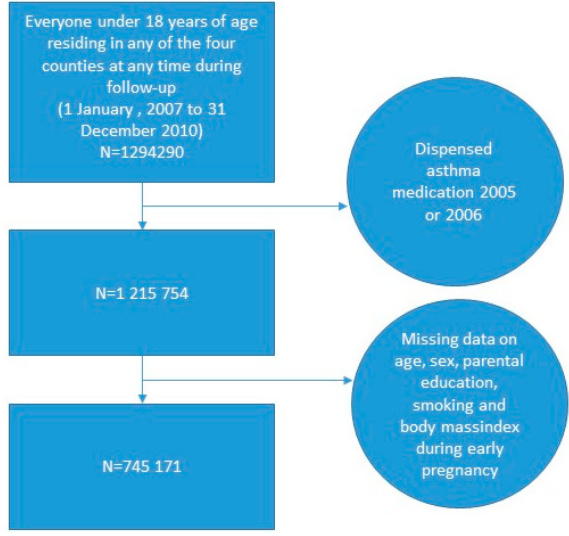
Figure 3. Study Figure 3. Study flow-chart.